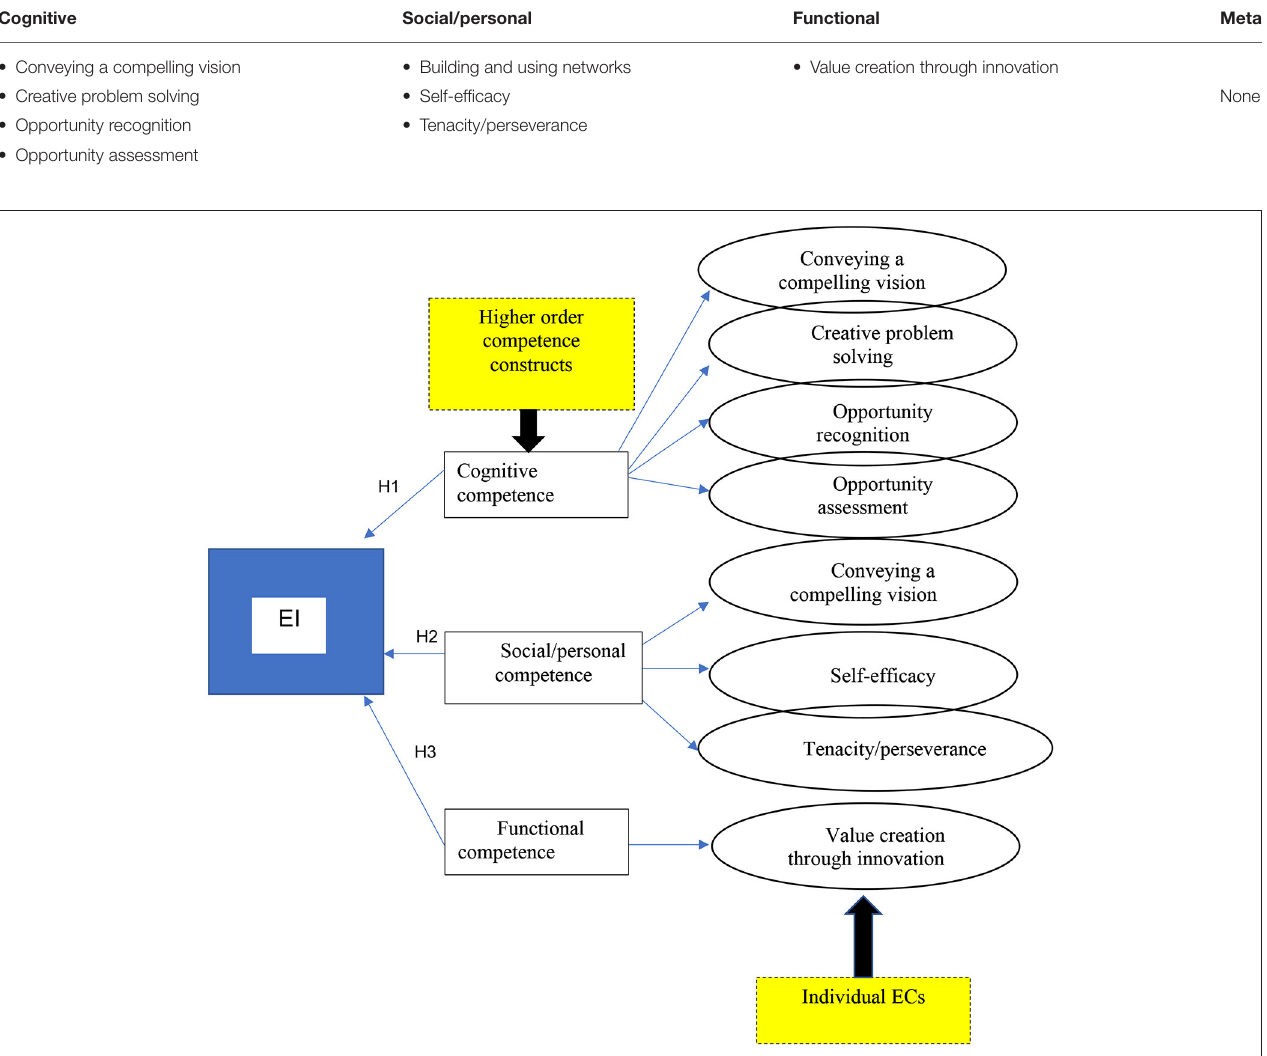
FIGURE 3 | The entrepreneurial intention- (EI-) competency higher-order category